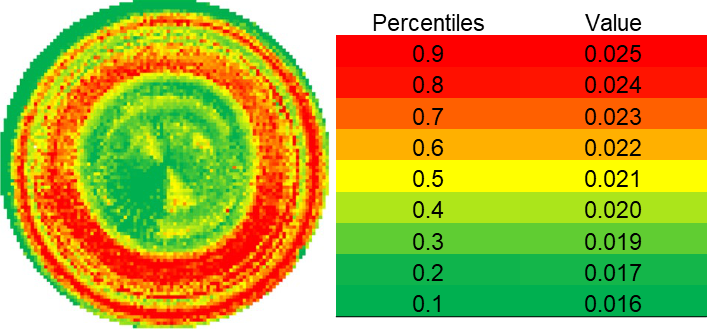
Figure 26. Raster of Livox ® Mid–40 field of view, colorized by range of distance measurements per cell over duration of three-hour indoor experiments.